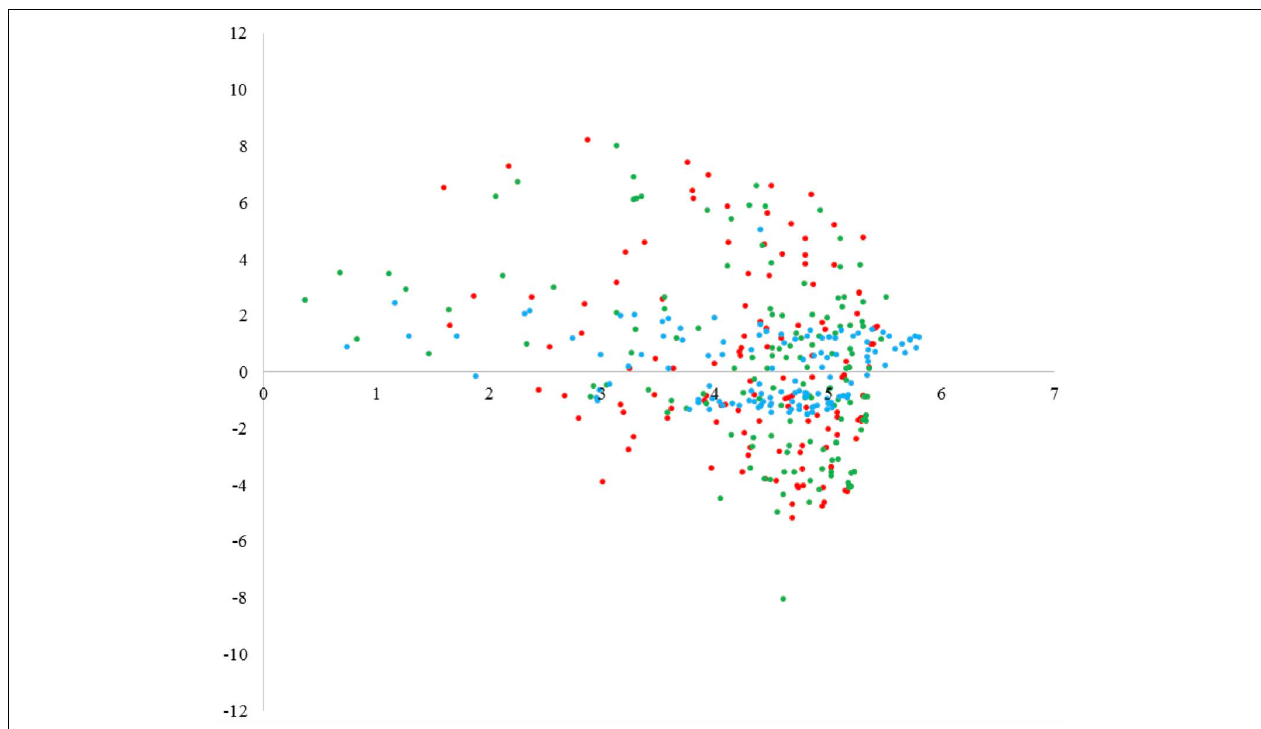
FIGURE 6 | Results of the PCA on considered aspects related to teacher and students and positive emotions: Score plot for the principal components 1 and 2 (red points: K-8; green points: K-9; blue points: